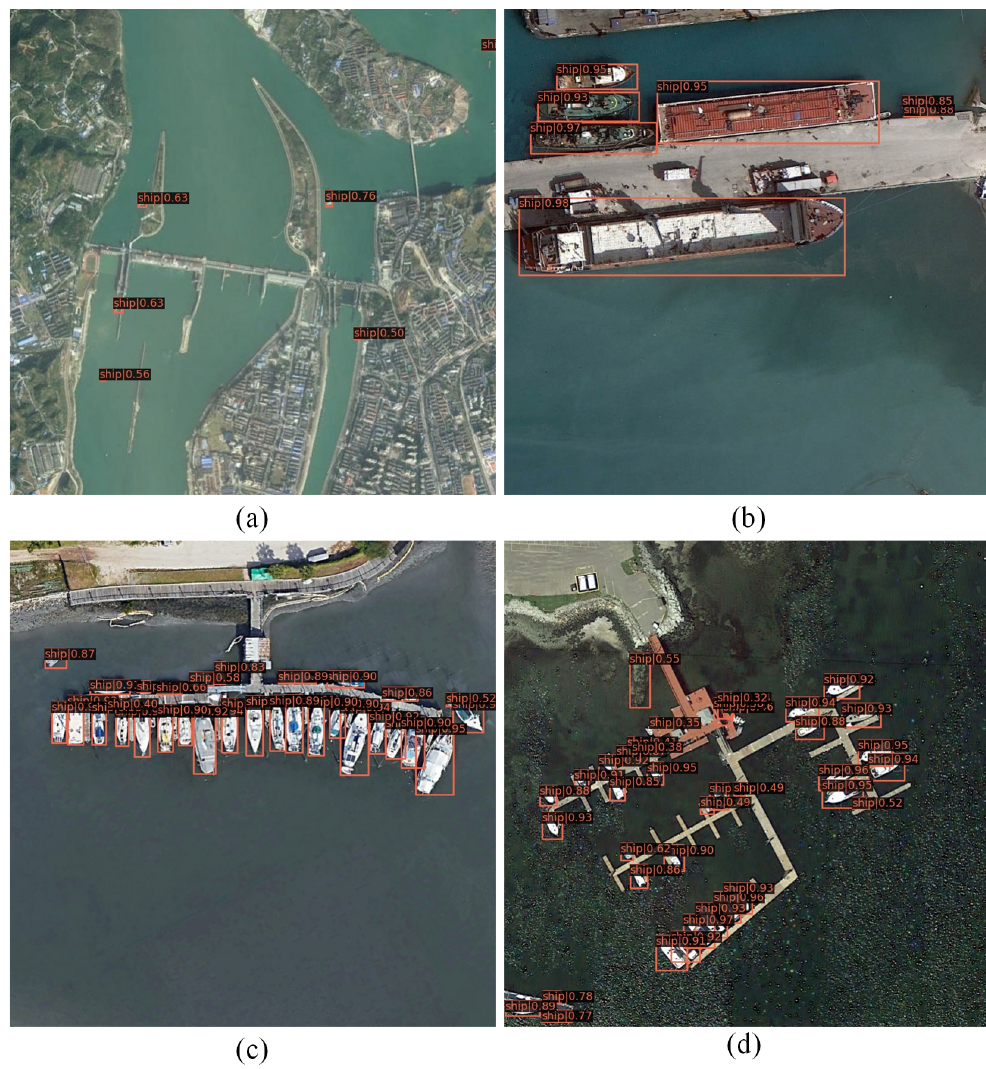
Figure 1. Some examples of ship detection in different situations. ( a ) Complex background; ( b ) multi- ple scales; ( c ) dense distribution; ( d ) different directions and aspect